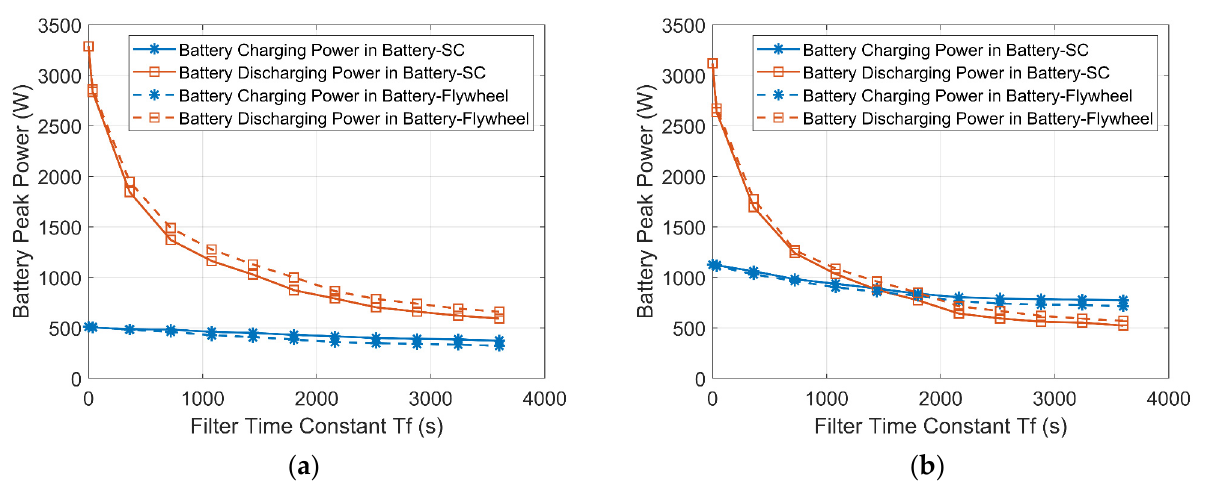
Figure 16. Variations of the maximum battery charging power and discharging power with increasing T f . ( a ) Wind-powered household-prosumer system. ( b ) PV-powered household-prosumer system.